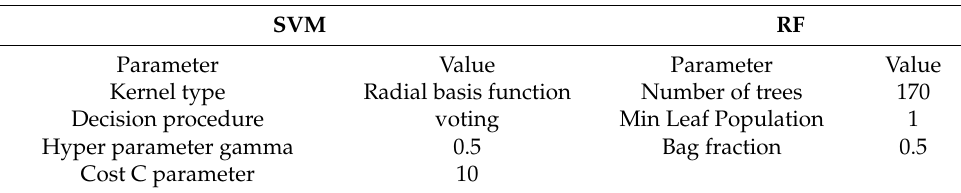
Table 2. The optimum hyperparameters of the SVM and RF algorithms used for surface water classification. SVM RF Parameter Value Parameter Value Kernel type Radial basis function Number of trees 170 Decision